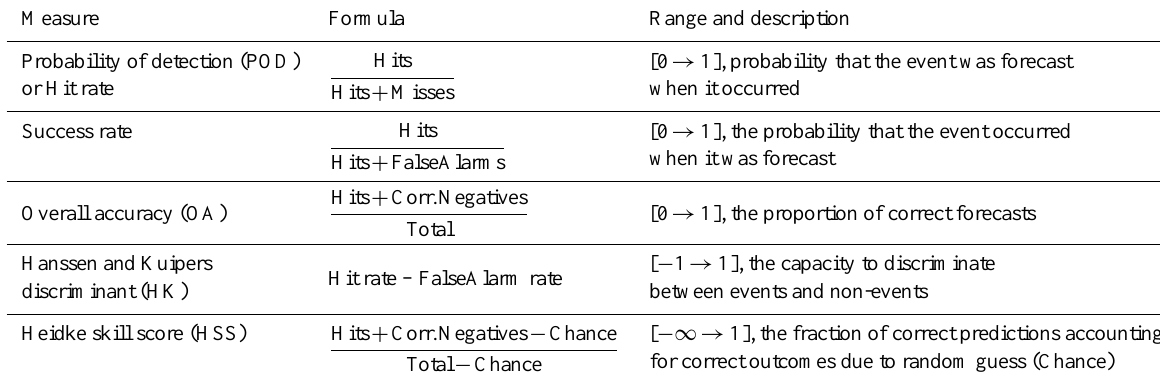
Table 1. Forecast verification measures and skill scores (Doswell et al., 1990; Wilks, 1995). Measure